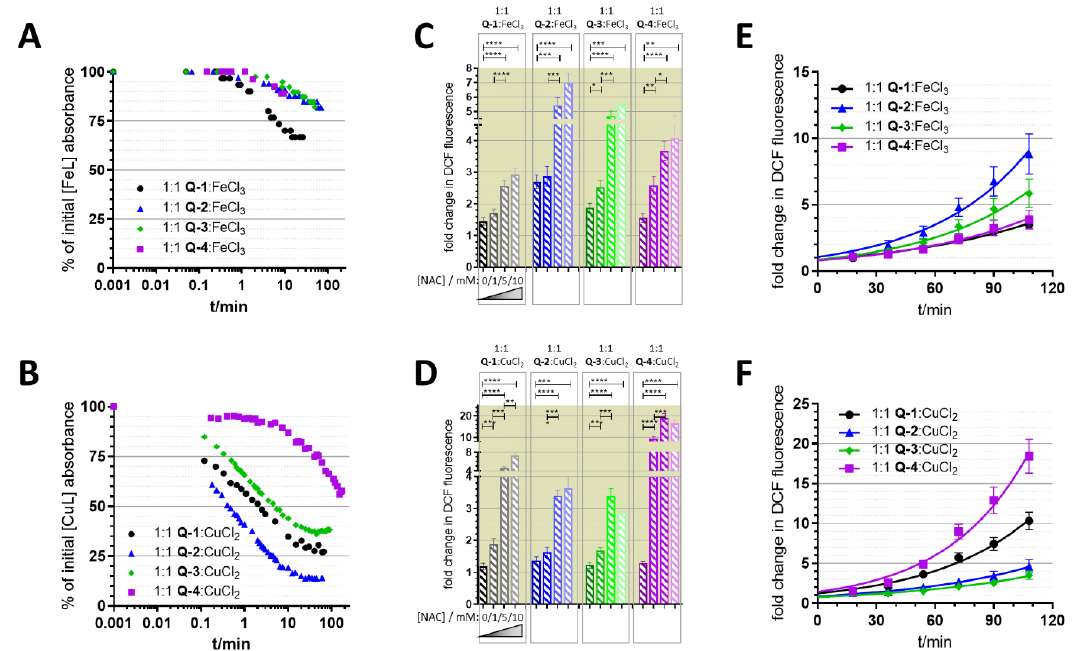
Figure 5. Reduction of the in situ formed iron(III) and copper(II) complexes from equimolar metal-to-ligand ratios with antioxidants was followed spectrophotometrically by the decrease in the respective absorbance maxima. ( A ) Time-dependent decrease of the absorbance values in equimolar 1:1 metal to ligand mixtures of FeCl 3 with Q-1 at 356 nm (black), Q-2 at 348 nm (blue), Q-3 at 334 nm (green) and Q-4 at 328 nm upon addition of 2.5 equivalents of ascorbate. ( B ) Time-dependent decrease of the absorbance values in equimolar 1:1 metal to ligand mixtures of CuCl 2 with Q-1 at 370 nm (black), Q-2 at 372 nm (blue), Q-3 at 368 nm (green) and Q-4 at 430 nm upon addition of 5 eq GSH. ( C / D ): fold changes in DCF-fluorescence (λ EX = 485 nm; λ EM = 535 nm) induced by a 2 h long incubation with 6.25 µM of iron(III) ( C ) and copper(II) ( D ) complexes in the presence of increasing concentrations of N-acetyl cysteine (NAC) (indicated by fading color from 0 to 1, 5, 10 mM). Results of complexes of Q-1 are shown in black, of Q-2 in blue, Q-3 in green and Q-4 in purple. ( E , F ) Kinetics of the DCFDA-oxidation reactions in the presence of 10 mM NAC from panels ( C , D ). *: p ≤ 0.05, **: p ≤ 0.01, ***: p ≤ 0.001. ****: p ≤